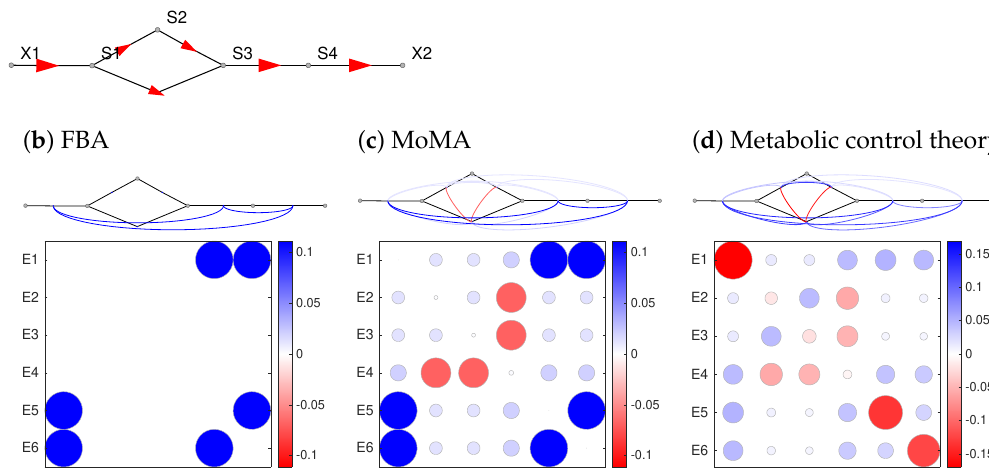
Figure 5. Enzyme synergy effects in a linear pathway with alternative routes. The (scaled) synergisms towards a fitness-relevant objective (e.g., biomass production) can tell us about epistasis. ( a ) network structure. A conversion from S 1 to S 3 can occur directly or via the intermediate S 2 . The following plots show synergy effects for double inhibitions predicted by FBA ( b ) or MoMA ( c ). To simulate enzyme inhibitions, a flux decrease to 90 percent of the original value was imposed by setting a bound at 0.9 times the unperturbed reaction flux. The double inhibition of an enzyme is simulated by applying the inhibition twice, i.e., leading to a relative flux decrease factor of 0.81. Synergy effects are shown by line colours (red: aggravating, blue: buffering) and as a matrix. Colour ranges span the observed synergy effects in each panel (red: negative; white: zero; blue: positive). Small values, below one percent of the maximal absolute value, are not shown. ( d ) Synergy effects computed by Metabolic Control Theory, assuming common modular rate laws and half-saturated enzymes. A model ensemble with saturation values sampled from uniform distributions yields almost the same results on average. Also a different rate law (the simultaneous binding modular rate law) yields very similar results (see Supplementary Figure S4). Compare Figure 3 for synergy effects in E. coli